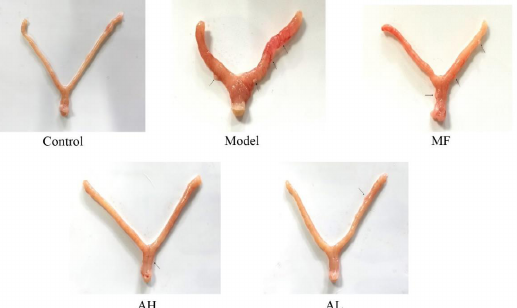
Figure 6. Representative images of rat uterine after AH and AL treatments. The arrow points out the location of the nodule in the uterine tissue.